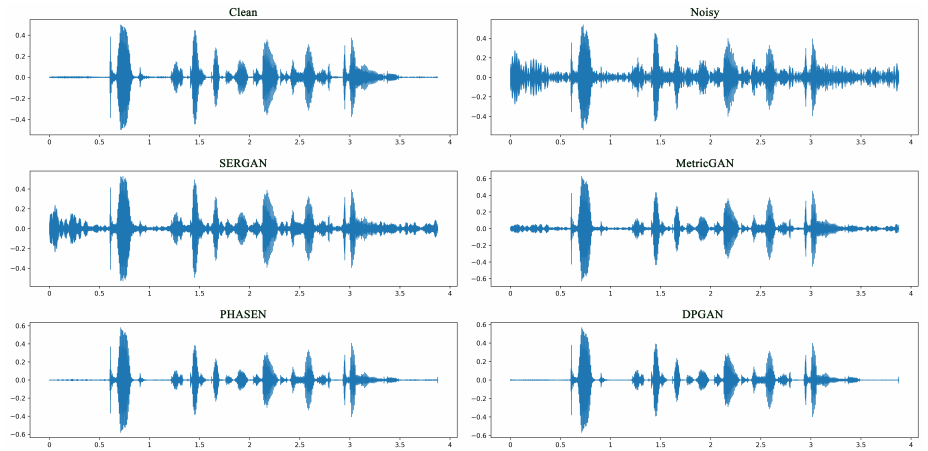
Figure 6. A comparative waveform plot of the enhancement effect of low-frequency noise at higher signal-to-noise ratios is shown. From left to right and top to bottom are pure speech, noisy speech, and the enhanced effects of SERGAN, MetricGAN, PHASEN and DPGAN, respectively.